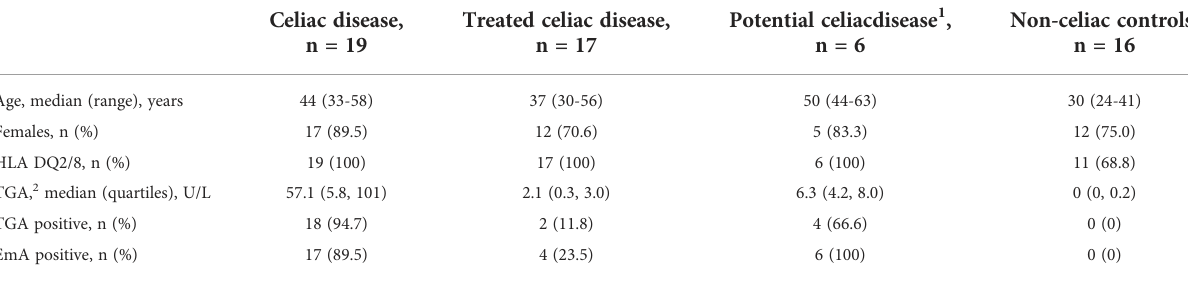
TABLE 1 Clinical and serological fi ndings and celiac disease-associated genetics of the 58 study patients.